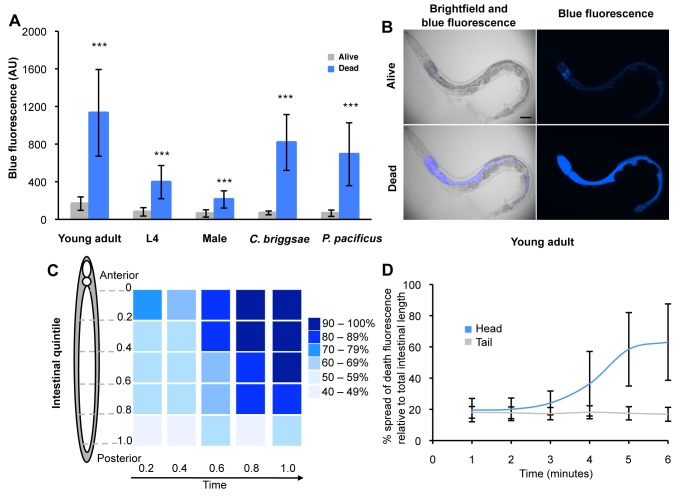
Characteristics of DF.(A) DF induced by hot pick killing in young WT adult (N = 87), L4 (N = 26), and male C. elegans (N = 25), and in other nematode species C. briggsae (N = 26) and P. pacificus (N = 49). ± SD, ***p<0.001. L4 larvae and adult males show smaller increases in DF than adult hermaphrodites, perhaps due to their smaller size. (B) Typical fluorescence increase in young adult worm killed by a hot pick. (C) Fluorescence increases in an anterior to posterior wave. Figure shows mean fluorescence intensity (values normalized to highest value in each individual) at 5 points along the intestine of animals dying of old age (N = 29). Due to individual variation (range, 1 h 55 min–5 h 30 min, mean ∼3 h), the duration of each observation was divided into 5 equal points for measurement. T = 0 is the point at which time-lapse photography of dying (late stage C) worms was initiated. (D) DF will not propagate in a posterior to anterior wave. Head, int1 and int2 anterior intestinal cells; tail, int9 posterior intestinal cells.